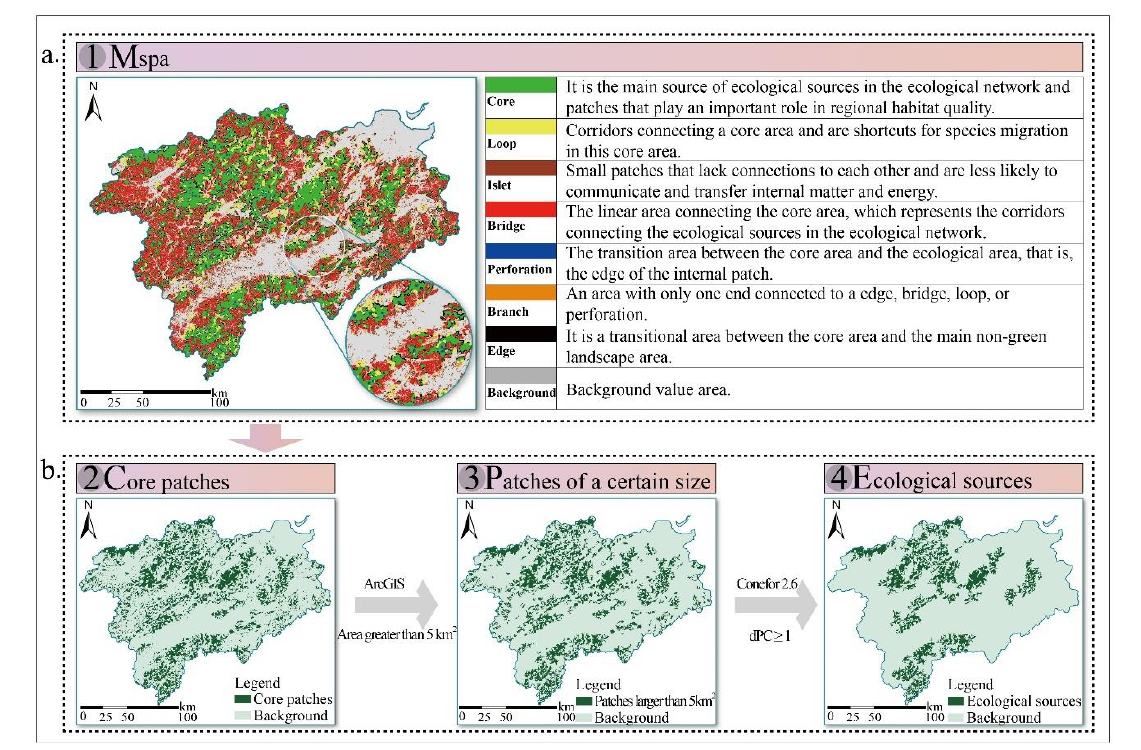
Figure 3. Process of ecological source selection: MSPA ( a ) and connectivity analysis ( b ).